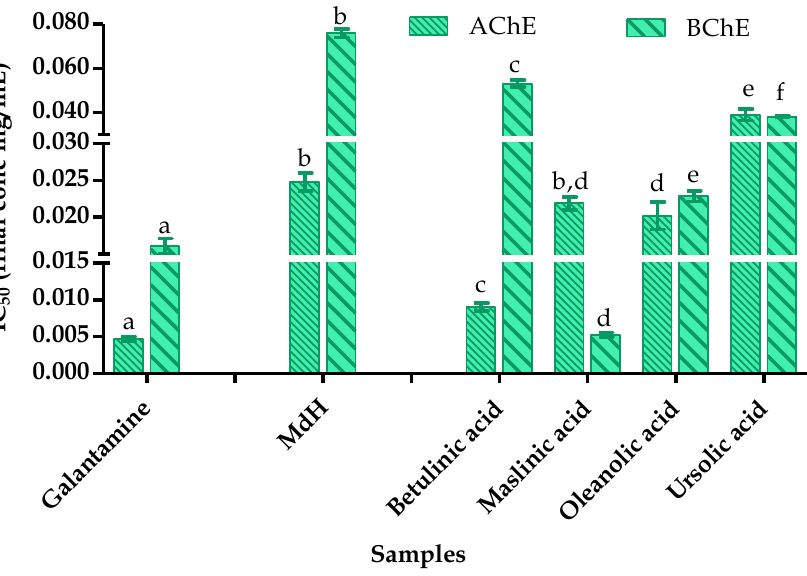
Figure 7. AChE and BChE inhibition by galantamine and n -hexane fraction of M. diffusa and identified terpenes expressed as IC 50 values in mg/mL. In each test, the values with the same letter (a, b, c, d, e, f) are not significant different at the p > 0.05 level, 95% confidence limit, according to one-way analysis of variance (ANOVA).